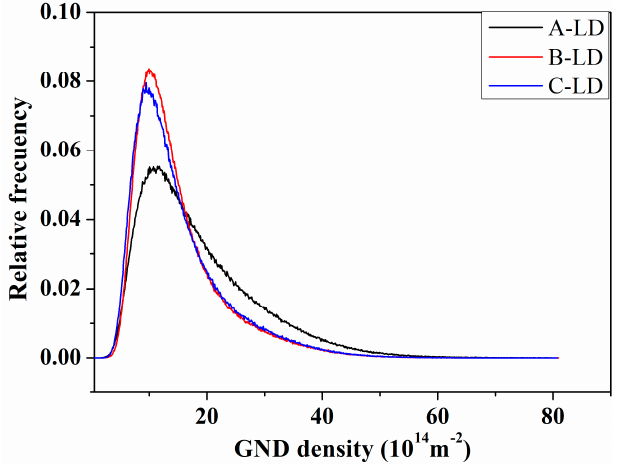
Figure 9. The statistics of the GND density.